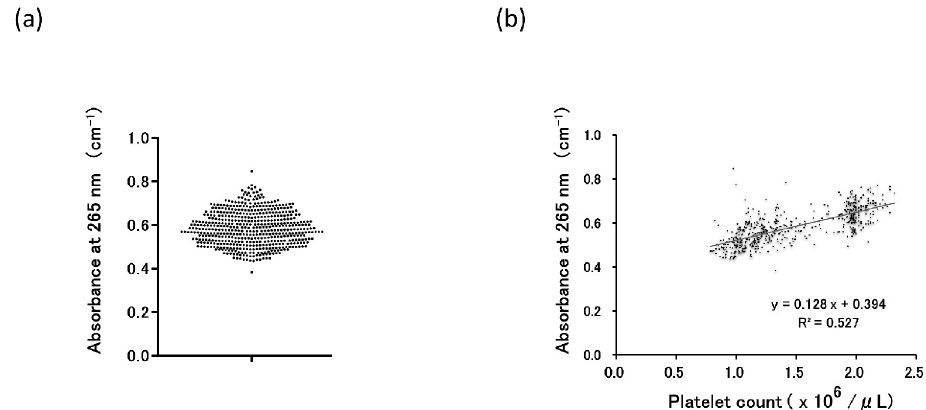
Fig 7. Absorbance (265 nm) of PC samples. PC samples (n = 520; 100-fold dilution) were applied to spectrophotometric analysis to determine absorbance at 265 nm. (a) A dot plot of 520 independent analyses is shown. (b) Linear regression analysis of platelet counts and absorbance at 265